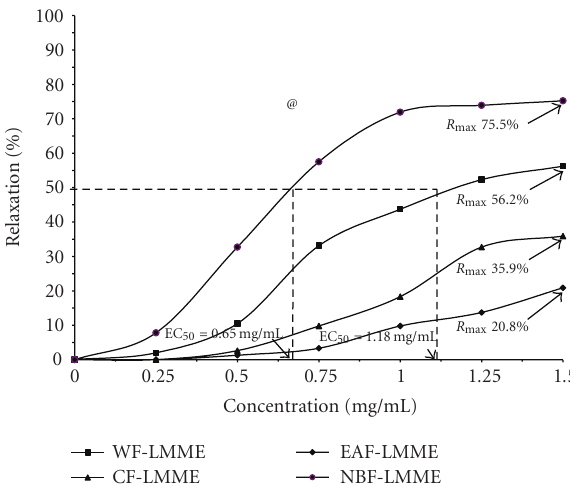
Figure 1: Median inhibitory concentration of and relaxation response to Loranthus micranthus methanolic extract fractions (LMME) by rat aorta rings precontracted with norepinephrine.